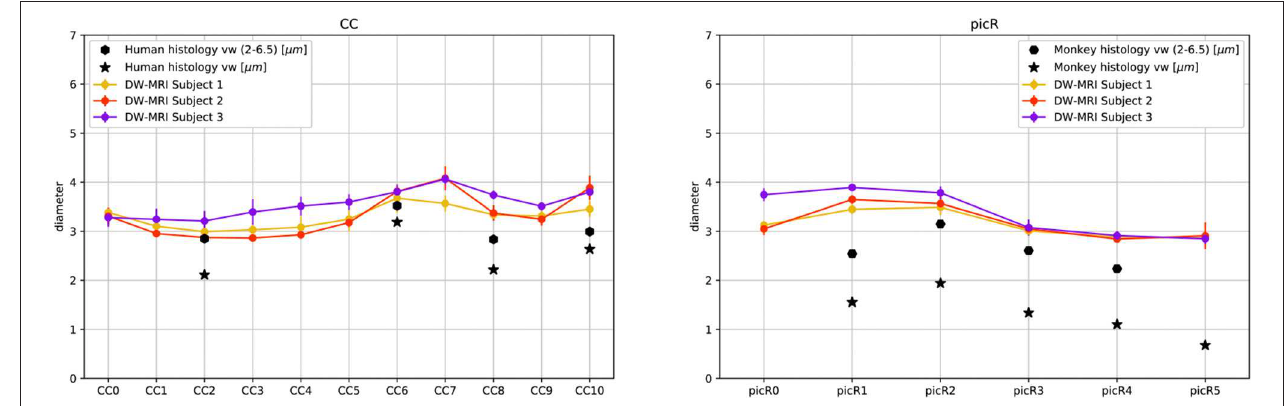
FIGURE 6 | DW-MRI cylinder diameter distribution of CC and PIC sectors compared to histological mean volume-weighted axon diameter from human (CC) and monkey (PIC) histology. Star markers represent the means of volume weighted histological distributions; hexagon markers represent the means of volume weighted cylinder distributions in the range 2.0 µ m to 6.5 µ